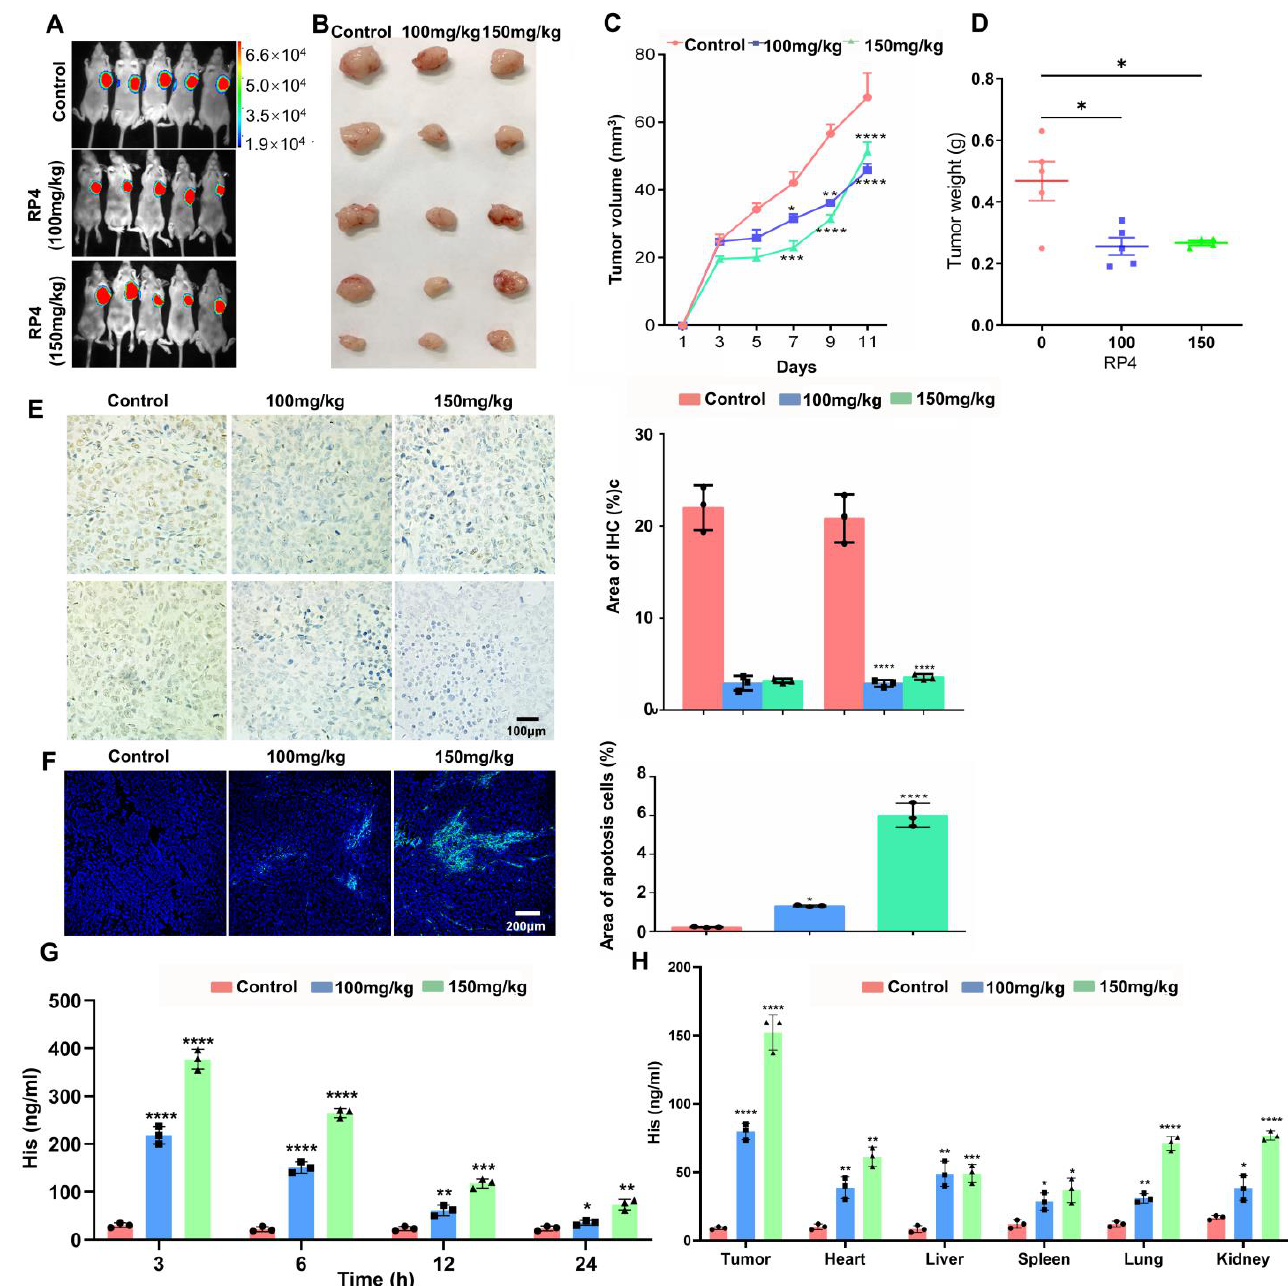
Figure 5. RP4 suppresses CRC xenografts growth in vivo without obvious toxicity. ( A ), Bioluminescence imaging of tumor growth. ( B – D ), Tumor weight and volume after RP4 treatment ( n = 5). ( E ), Immunohistochemistry analysis of Ki67 and Bcl2 expression in tumor. ( F ), RP4 induces apoptosis in tumors, assessed by TUNEL. ( G ), Serum ELISA of xenografted mice treated by PBS, 100mg/kg RP4, 150 mg/kg RP4. ( H ), ELISA of heart, liver, spleen, lung, and kidney treated by PBS, 100mg/kg RP4, 150 mg/kg RP4. Data are expressed as mean ± S.D. Statistical analysis was performed with one-way ANOVA ( n = 3; * p < 0.05, ** p < 0.01, *** p < 0.001, **** p < 0.0001). Representative images from three independent experiments are shown. To assess the effect of RP4 on the lung metastasis ability of CRC in vivo , CT26-lucif- erase cells were injected into Balb/c mice to generate the lung metastasis model. Continu- ous RP4 treatment significantly suppressed the metastasis of CT26 cells in the lung tissue